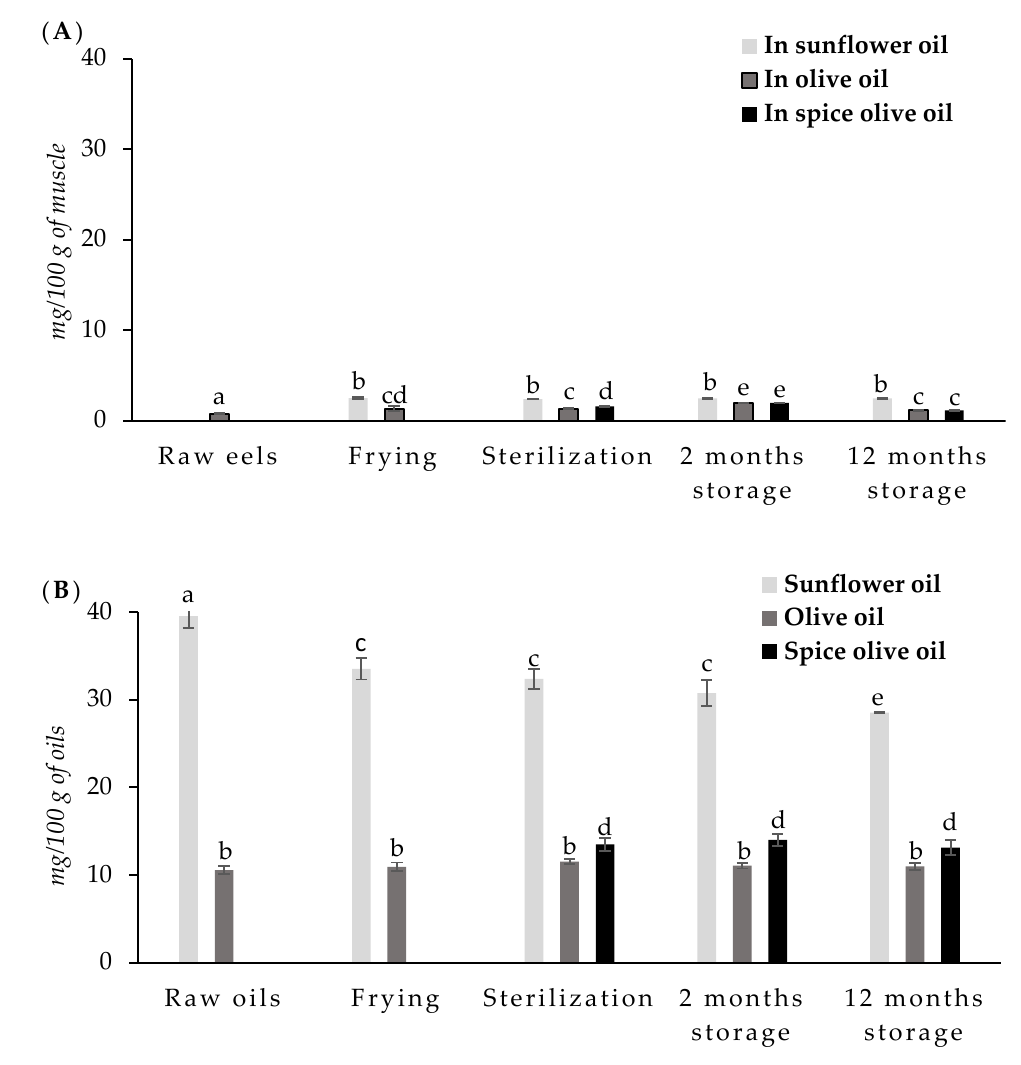
Figure 4. Vitamin E (mg/100 g) of European eel ( A ) and filling oils ( B ) after each step during the canning process and after 2 and 12 months of subsequent storage. a–e Mean values with different letters are significantly different ( p < 0.05).